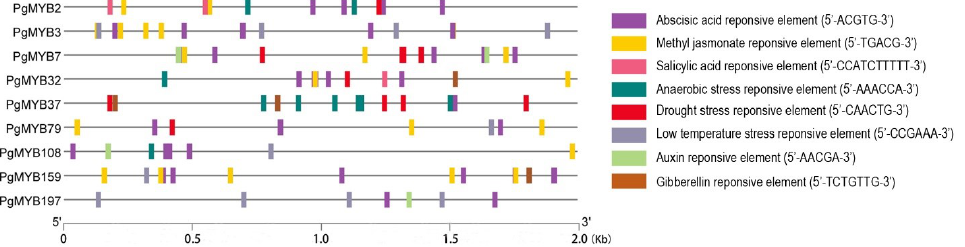
Figure 4. Promoter analysis of nine R2R3-type PgMYB genes. Abiotic stress-related cis elements are predicted using PlantCARE program. Conserved sequence of each cis-element is listed in parentheses.